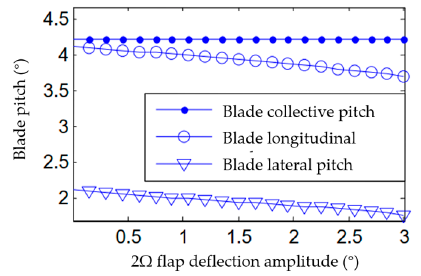
Figure 7. The effect of change in the 2 Ω flap amplitude on the blade pitch